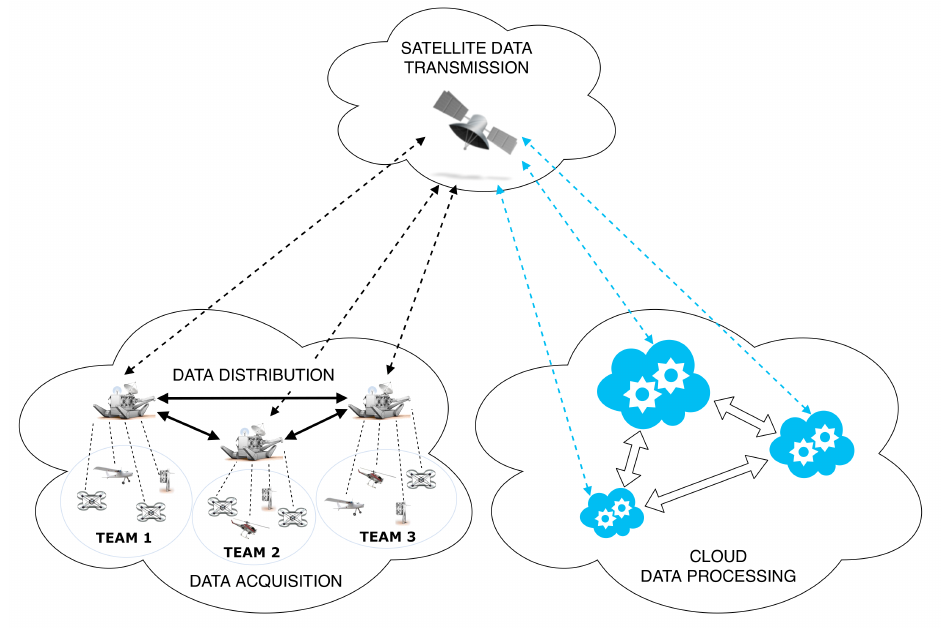
Figure 3. Topology of the SHERPA network with the